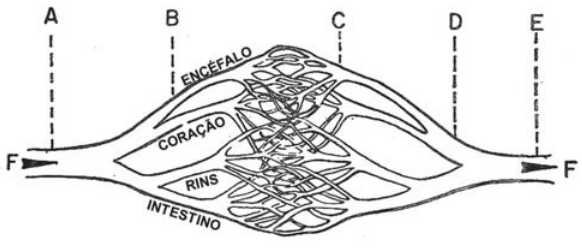
Fig. 4 - Ilustração das propriedades das resistências hidráulicas no sistema circulatório: A, B, C, D, E representam segmentos sucessivos de uma rede vascular (artéria, arteríola, capilar, vênula, veia, respectivamente). Os elementos formadores de um segmento são resistências em paralelo. Os segmentos, por sua vez, dispõem- se como resistências em série. Retirado de Silva Jr MR. Fisiologia da circulação. 2ª ed. São Paulo:Edart;1977. p.11